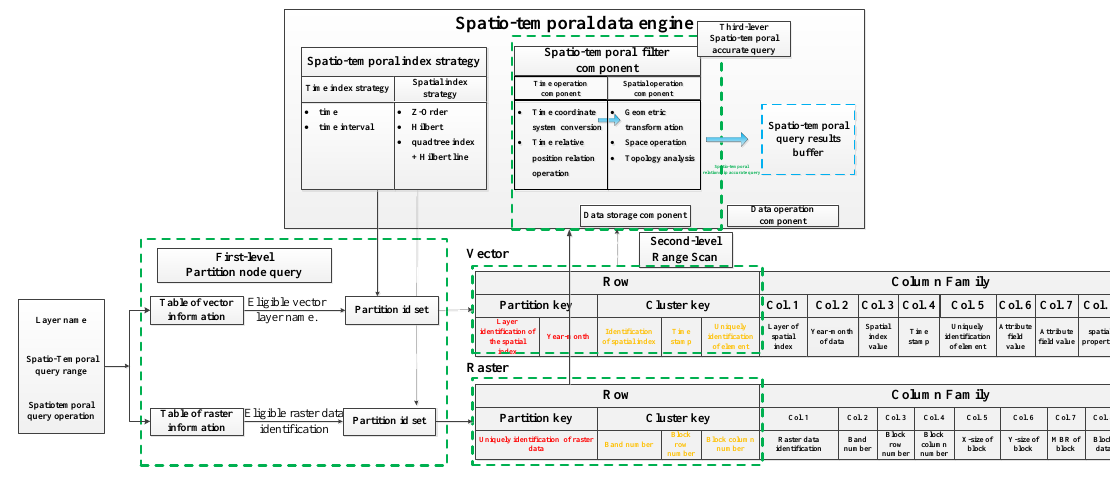
Figure 6. Integrated retrieval of vector and raster